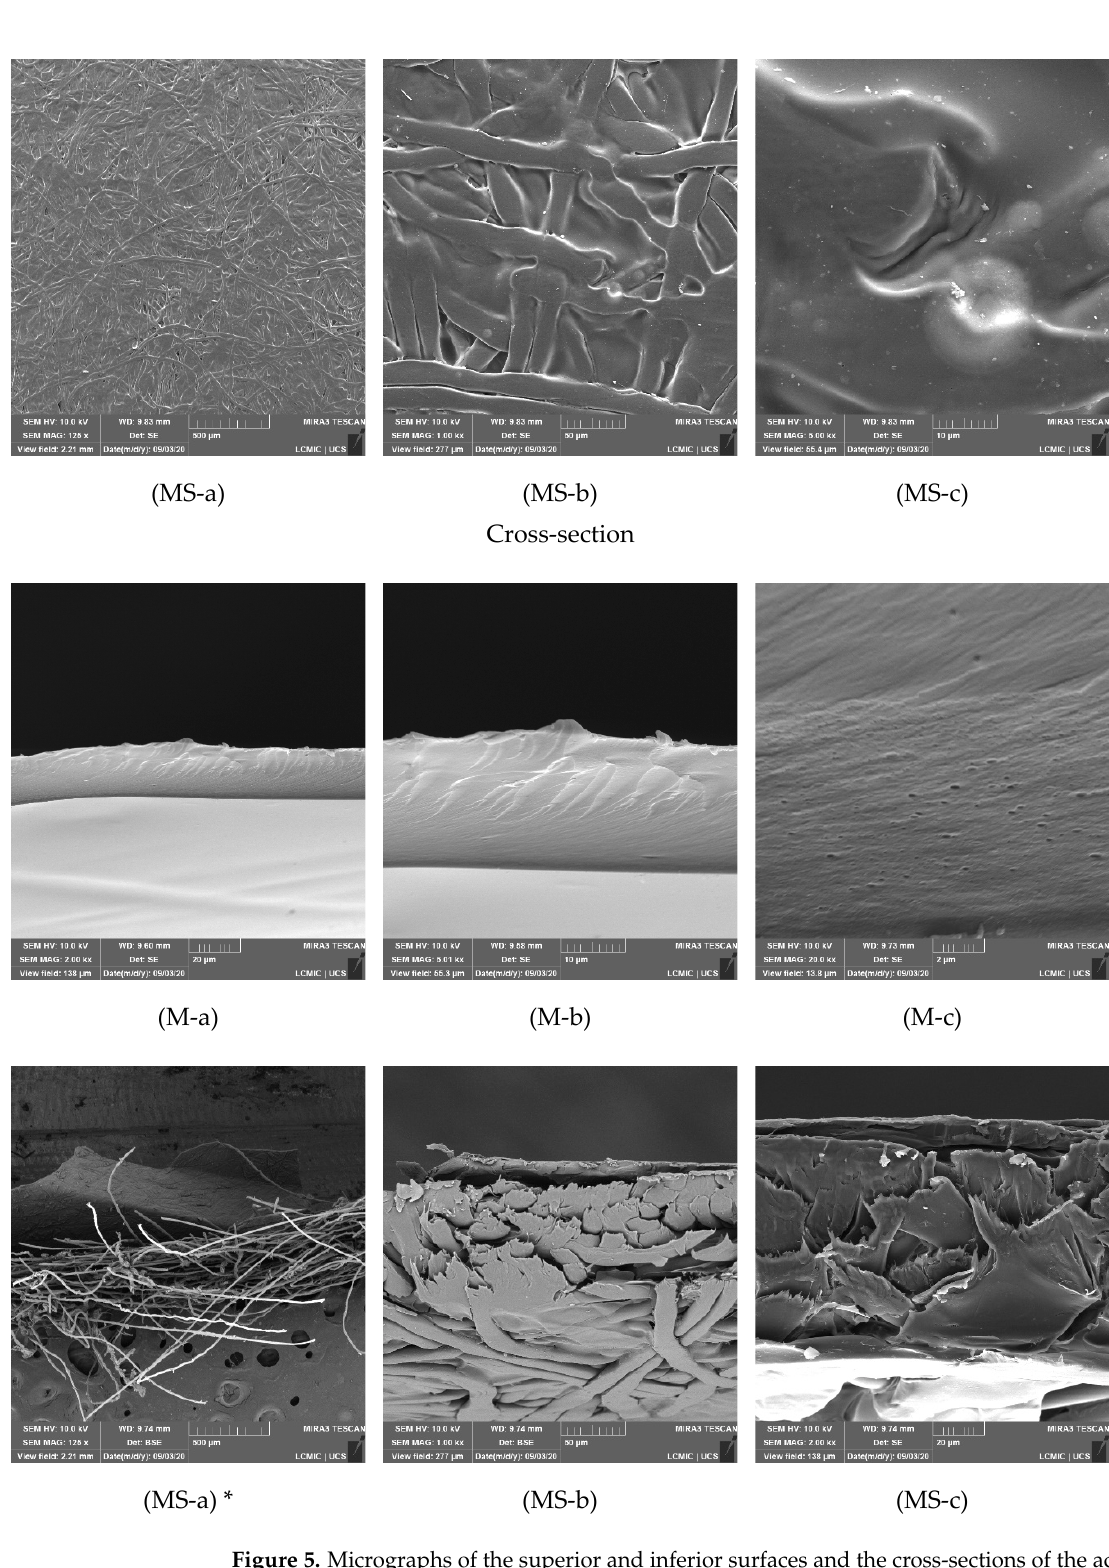
Figure 5. Micrographs of the superior and inferior surfaces and the cross-sections of the active layers of the non-supported (M) and PET-supported (MS) chitosan membranes, at magnifications of 125 ( a ), 1000 ( b ), and 5000 ( c ) times. *—The cross-section of this membrane was obtained via cryogenic fracture; the cross-sections of the other MS membranes were obtained by cutting using a scalpel.